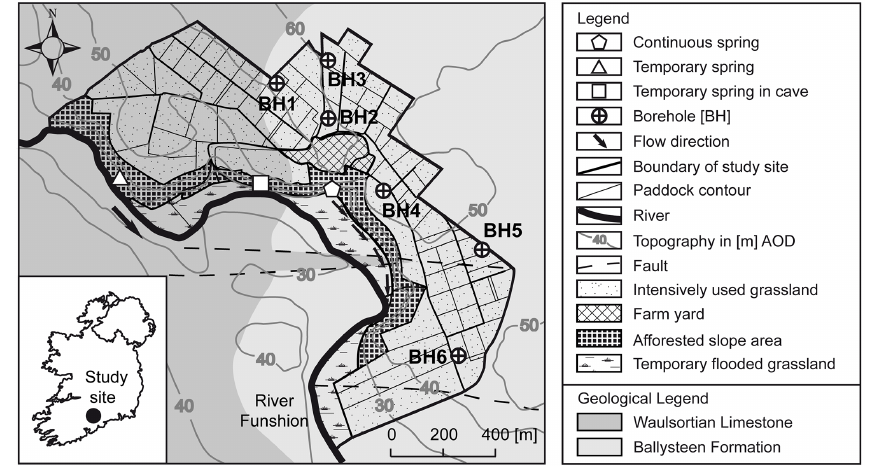
Figure 1. Site map for the study area. The smaller arrows indicate the water flow direction of the continuous spring in a ditch to the river.